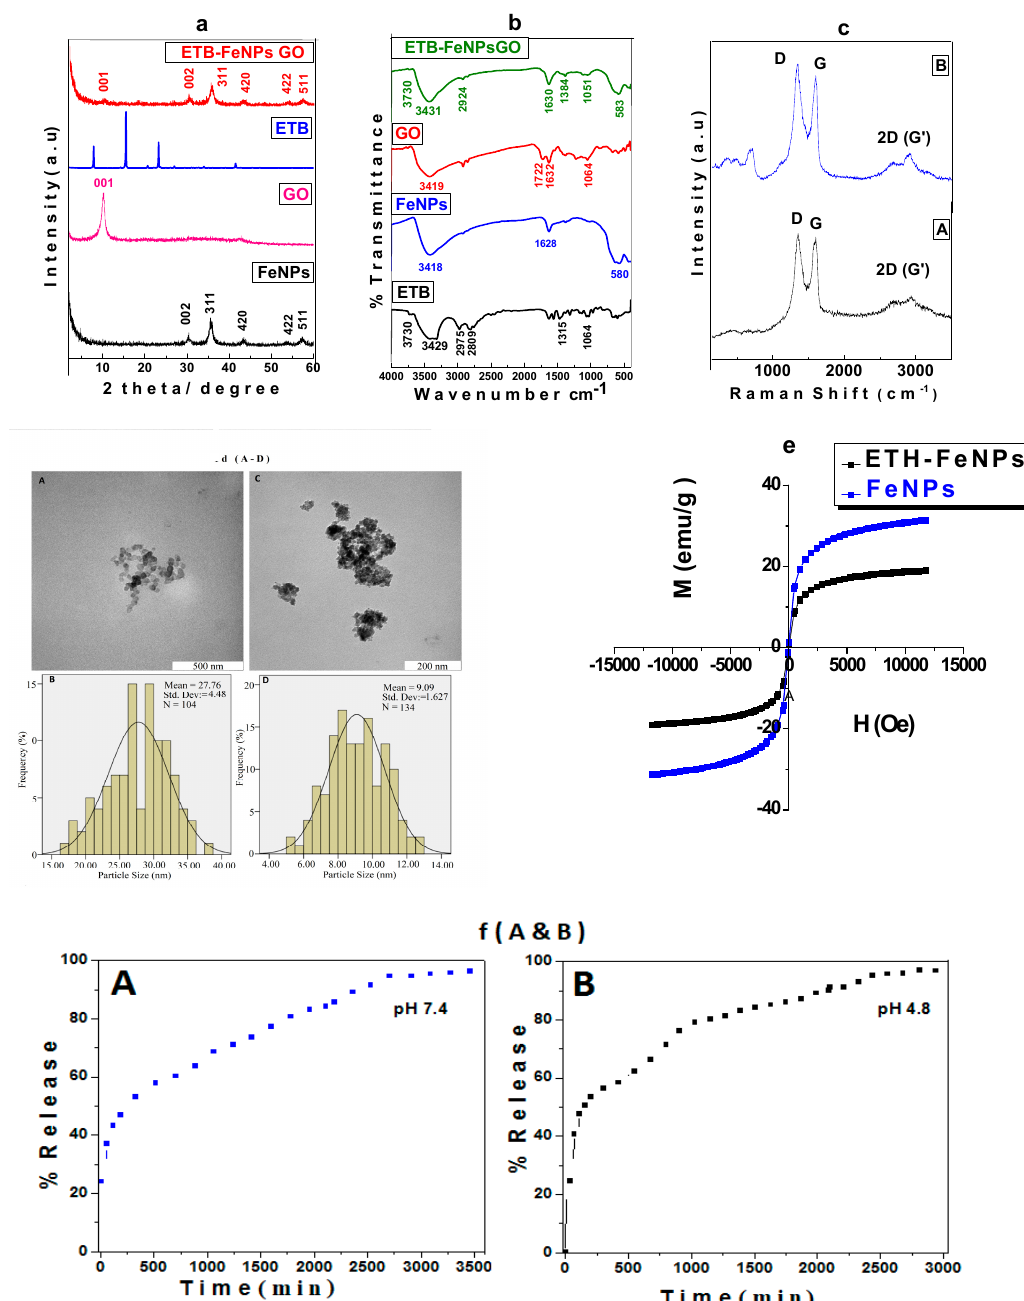
Figure 1. ( a ) X-ray diffraction patterns of iron oxide magnetite nanoparticles (FeNPs), free drug ethambutol (ETB), graphene oxide (GO), and anti-TB multifunctional nanoformulation (ETB-FeNPs-GO) ( b ) FTIR spectra of ETB, FeNPs, GO, and of ETB-FeNPs-GO; ( c ) Raman spectra of GO (A) and anti-TB multifunctional nanoformulation formulation ETB-FeNPs-GO (B); ( d ) Transmission electron micrograph (TEM) of FeNPs-GO (A) and their particle size distribution (B), TEM of anti-TB multifunctional nanoformulation (C) and their particles size distribution (D); ( e ) Magnetization plots of FeNP alone and multifunctional nanoformulation ETB-FeNPs-GO; ( f ) In vitro release profile of Ethambutol (ETB) from anti-TB multifunctional nanoformulation (ETB-FeNPs-GO) in PBS solutions of pH 7.4 (A) and pH 4.8